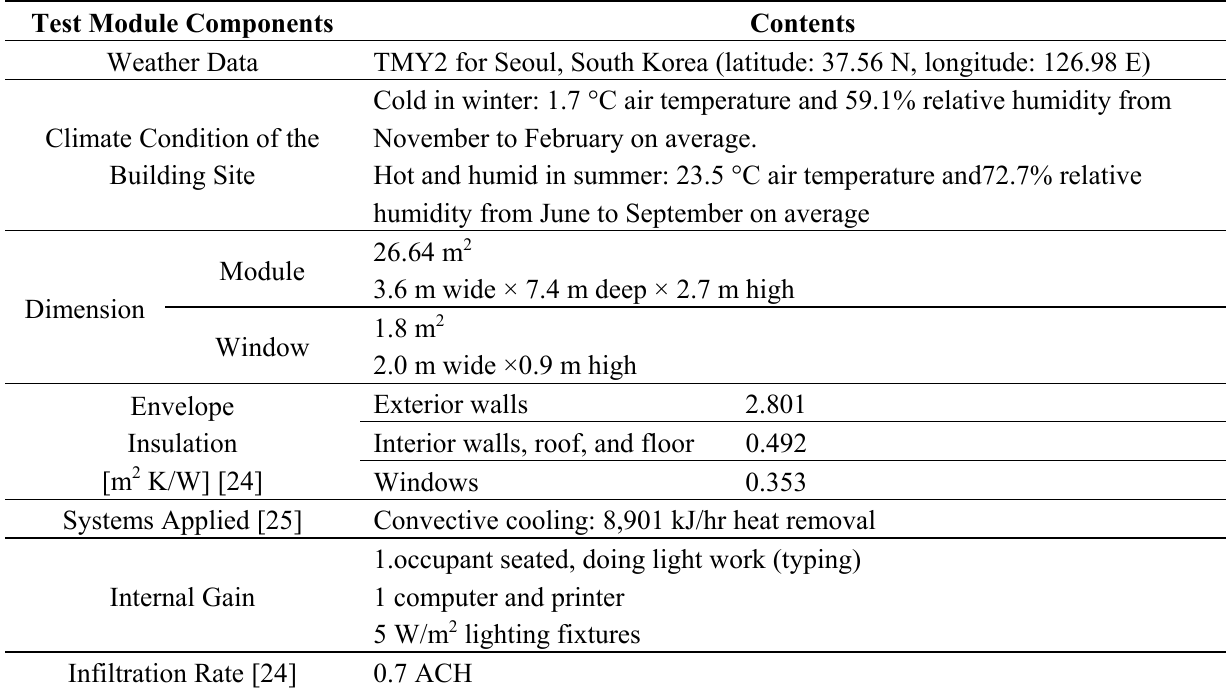
Table 5. Features of a test